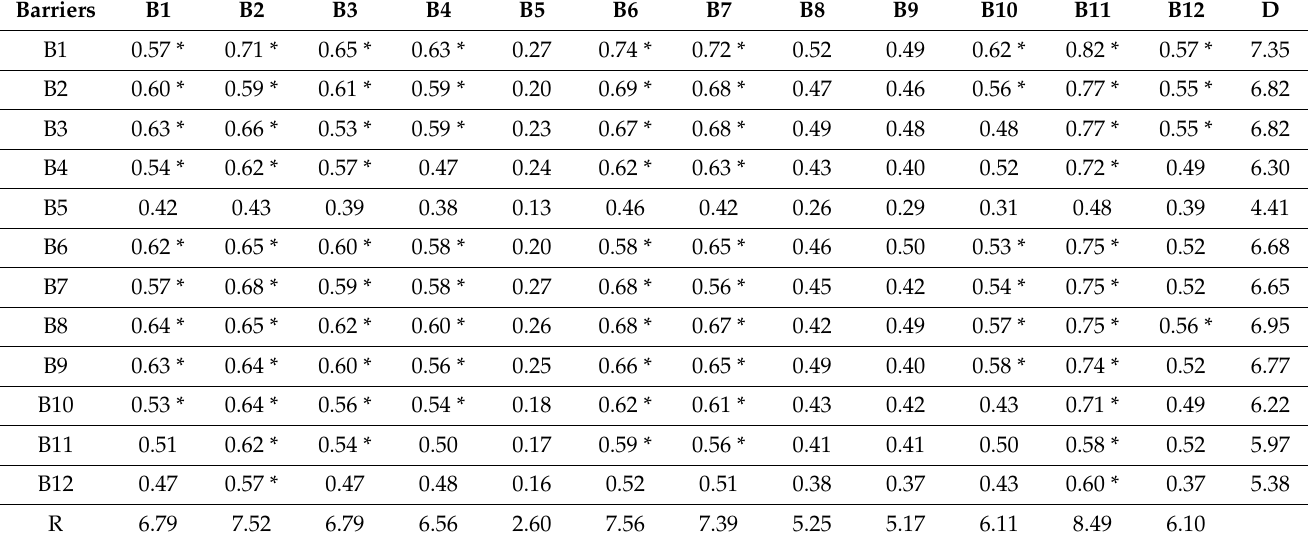
Table 7. Calculate the total-relation matrix